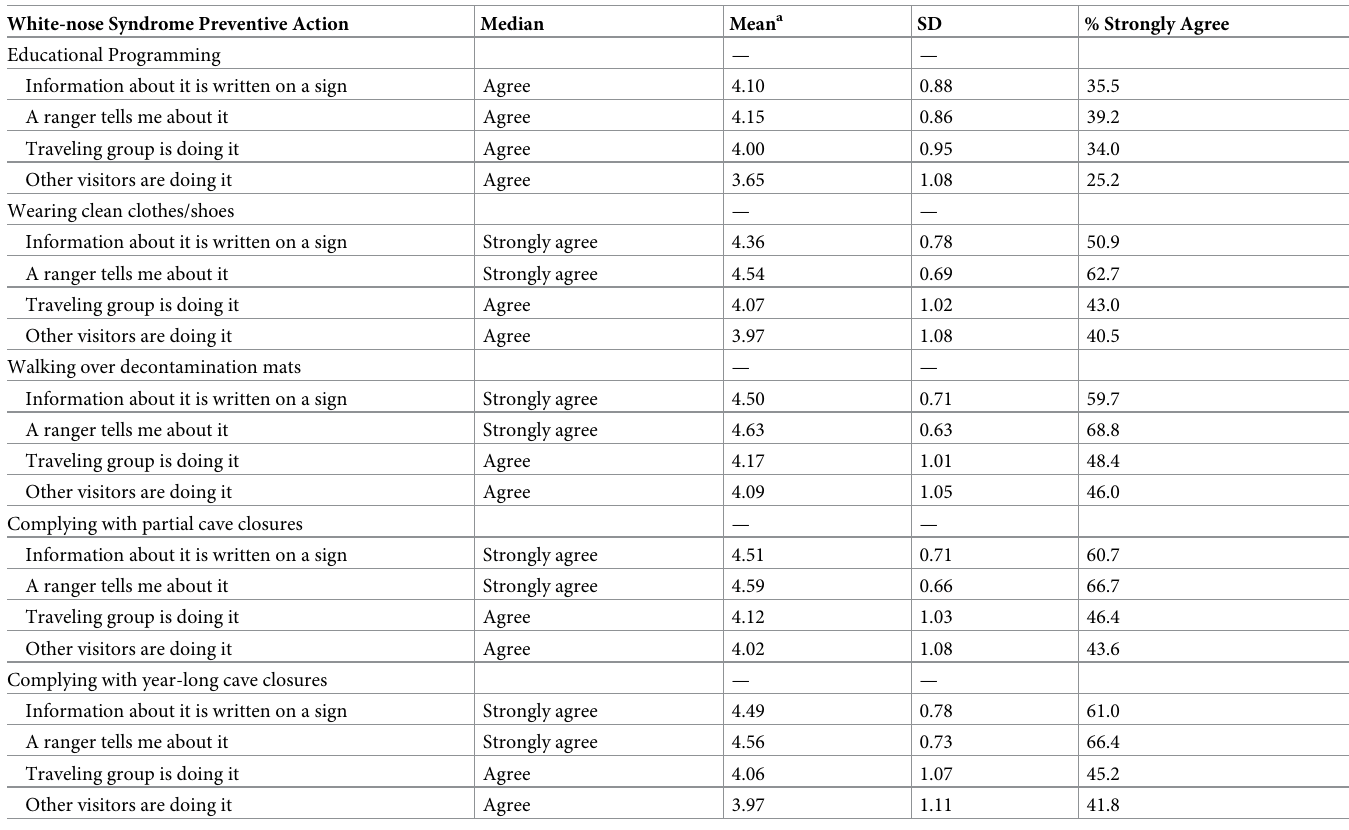
Table 3. Visitor subjective norm responses to the statement “I am more likely to do [white-nose syndrome preventative] action if [a ranger tells me to do it, the group I am traveling with is doing it, other visitors are doing it],” 2019. White-nose Syndrome Preventive